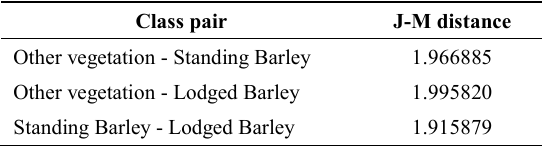
Table 2. Jeffries-Matusita distance for every pair of classes computed with all the MicaSense bands We trained and tested an RF classification model over approximately 50,000 randomly chosen pixels for each class using spatially dispersed training sites from Flight1 fields. This method achieves a spatially robust and minimally biased training set for the machine learning algorithm. The RF OOB error rate was 0.65% and the overall accuracy was 99.35%. The detailed confusion matrix with the User’s Accuracy (UA), the Error of Commission (EC), the Producer’s Accuracy (PA), and